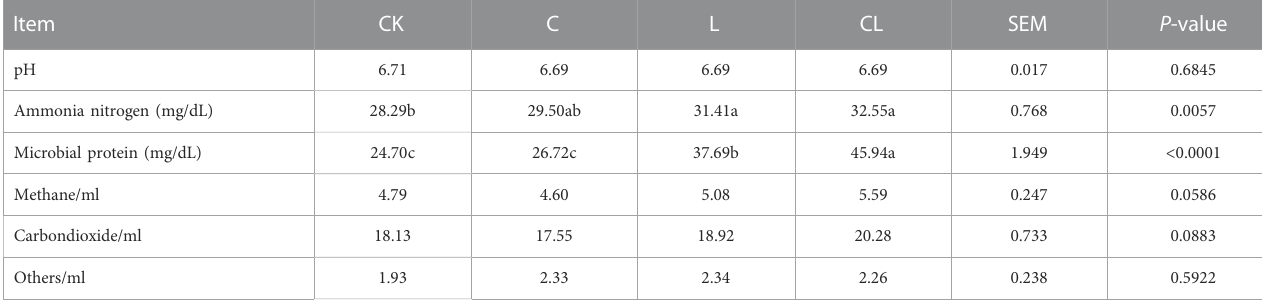
TABLE 6 In vitro fermentation parameters and ruminal gas production from Caragana korshinskii silage fermented in vitro for 72 h. Item